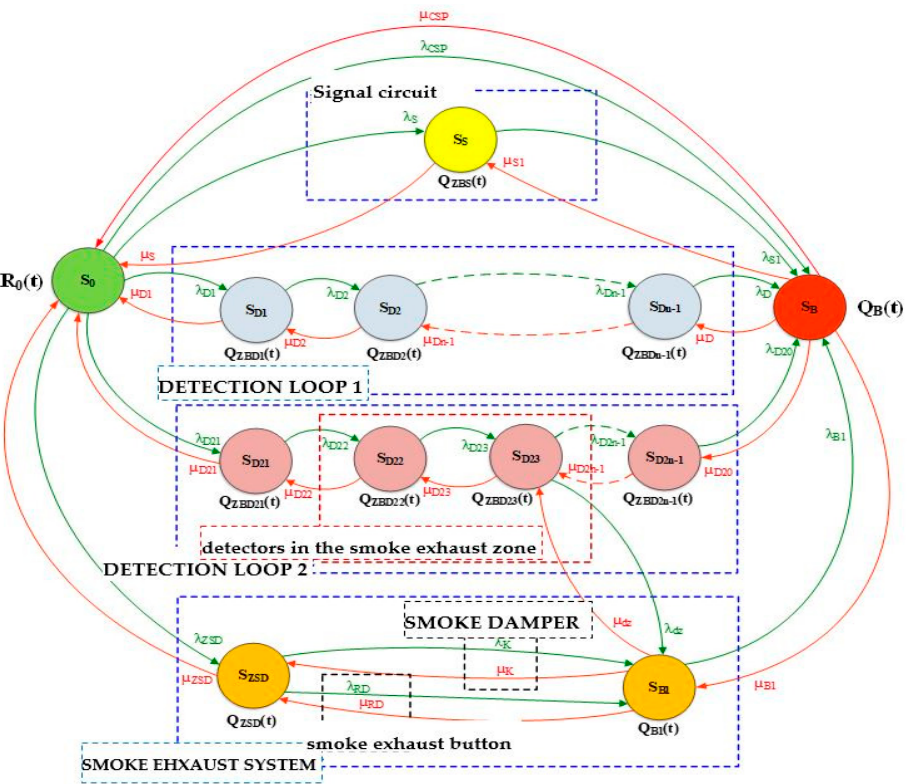
Figure 7. Relationships within a fire alarm system connected to a smoke exhaust control unit. Fire is detected by detectors connected to the FAS detection loop. Designations in the Figure: R O (t) is the probability function of an FAS staying in the S PZ state, Q ZB (t) is the probability function of an FAS staying in the S ZB state, Q B (t) is the probability function of an FAS staying in the S B state, λ ZB1 is the intensity of transitions from the S PZ state to the S ZB state, µ PZ1 is the intensity of transitions from the S ZB state to the S PZ state, λ ZB2 is the intensity of transitions from the Q ZB state to the Q B state, μ PZ is the intensity of transitions from the Q B state to the S PZ state.